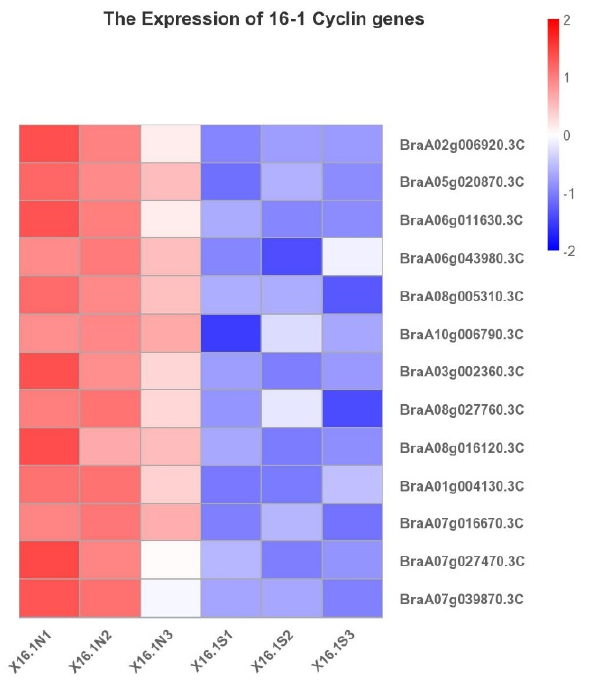
Figure 8. Transcriptomic expression analysis of the Brcyclin genes in the Chinese cabbage-cabbage translocation line 16-1. | log 2 FC| ≥ 1, FDR ≤ 0.01.